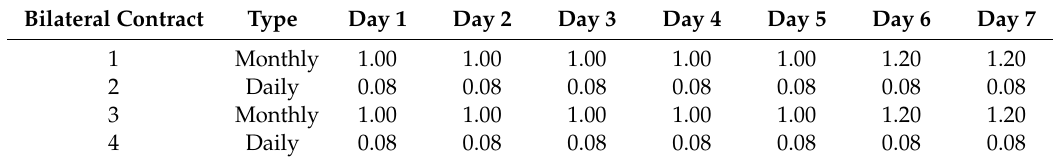
Table 12. Bilateral contracts—fixed term coe ffi cients by duration type and day. Bilateral